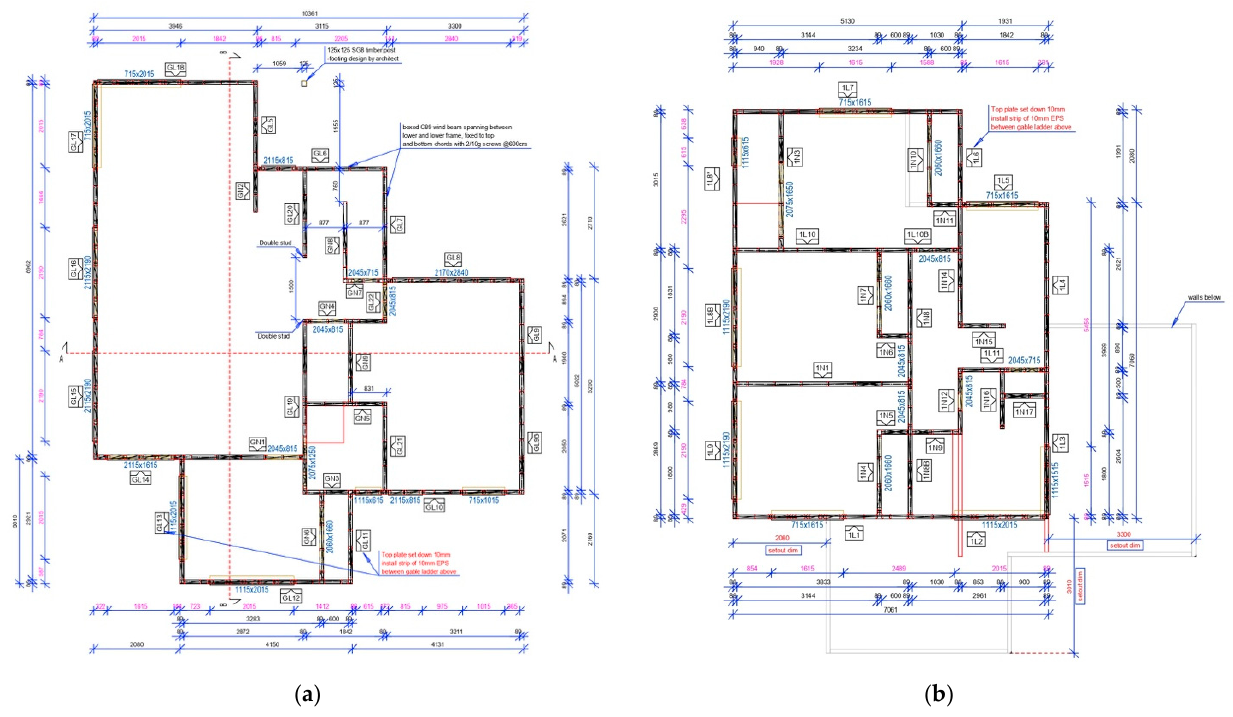
Figure 4. House B—light steel house plan ( a ) ground floor; ( b ) upper floor (all measurements are in millimetres and scaled at